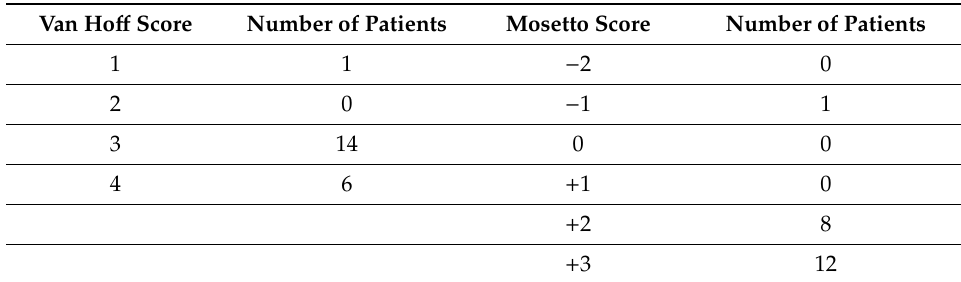
Table 4. Report on the evaluation of the state of graft integration at the last follow up according to Van Ho ff and Mosetto radiological scores